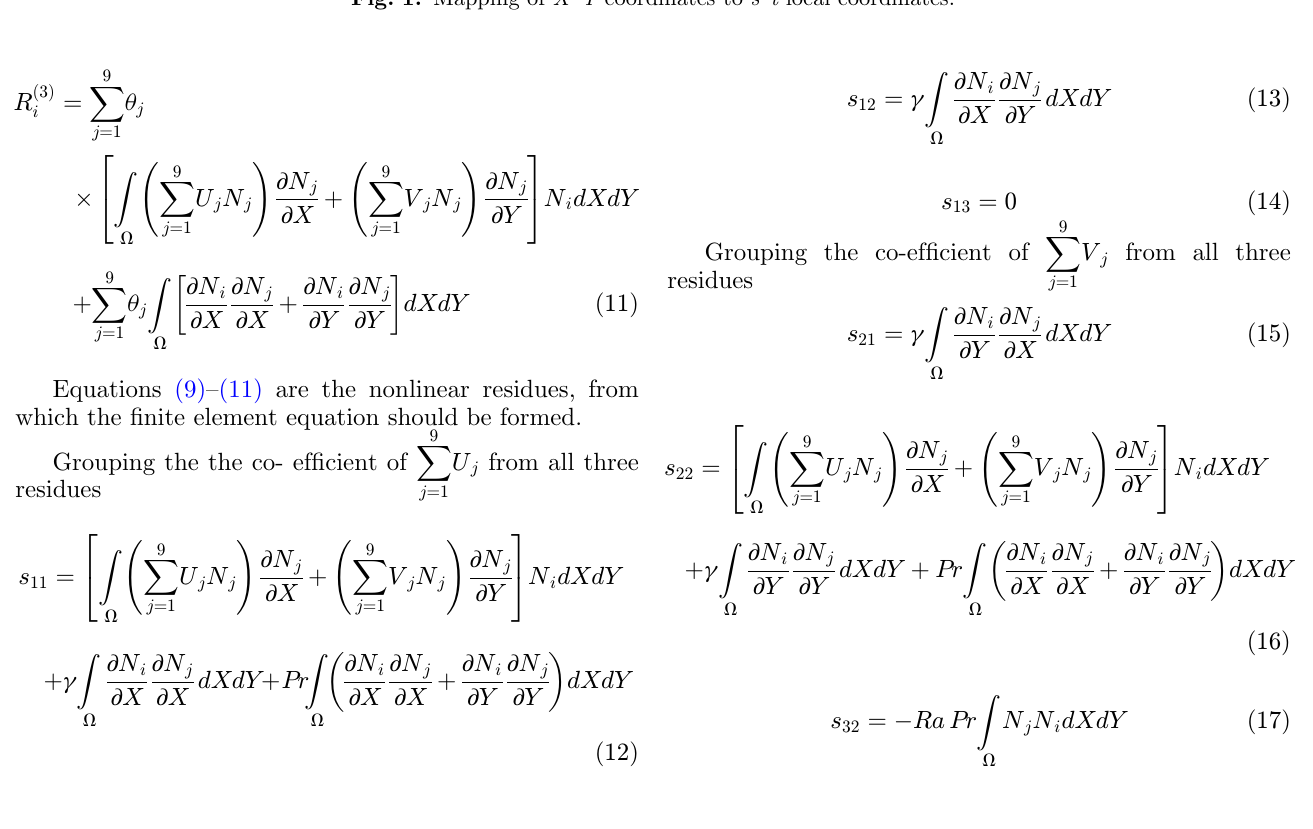
Fig. 1. Mapping of X – Y coordinates to s – t local